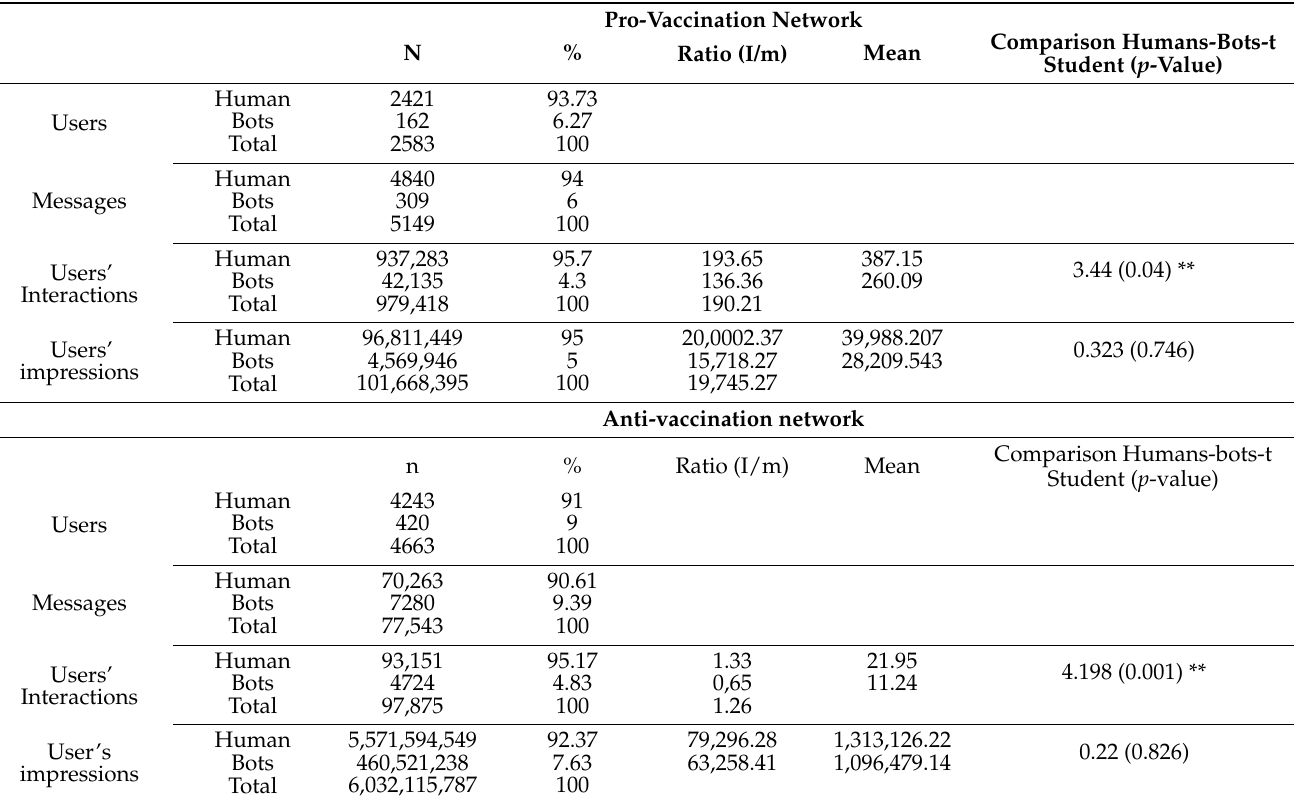
Table 1. Characteristics of users, impressions, and interactions in pro and anti-vaccination net- works.